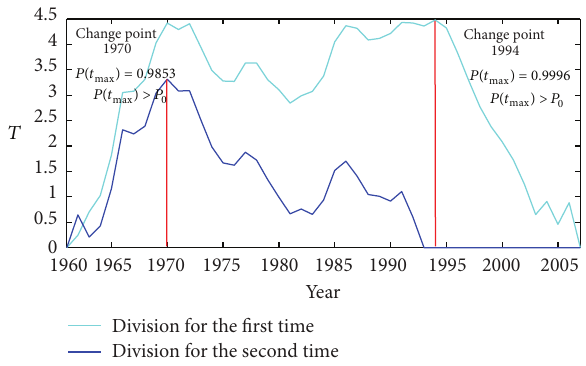
Figure 3: Segmentations and change points of annual runoff at Xianyang station.